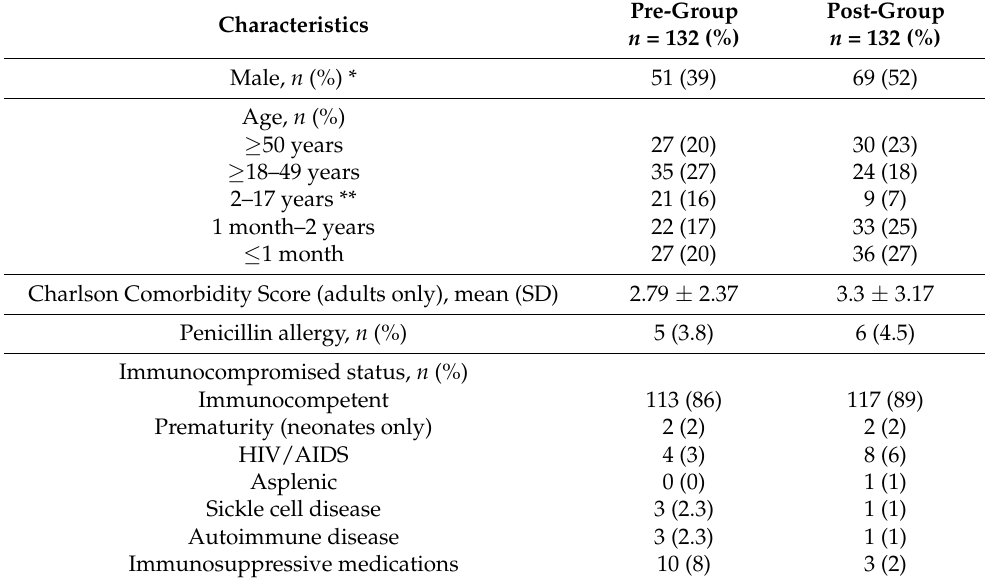
Table 1. Demographics of study